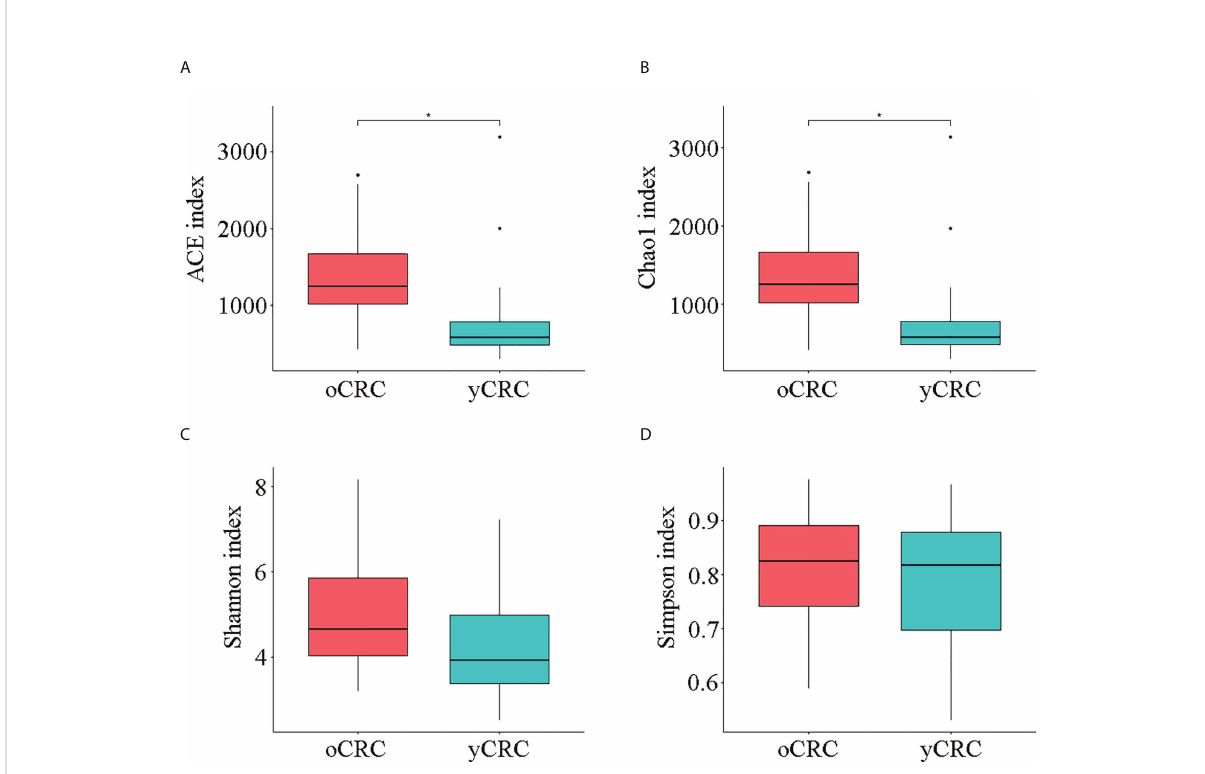
FIGURE 1 Diversity of tumor microbiota in patients with old-onset colorectal cancer (oCRC) and patients with young-onset colorectal cancer (yCRC). (A – D) Alpha diversity of the two groups was measured in terms of the ACE, Chao1, Shannon, and Simpson indices. Data represent the mean±SD.